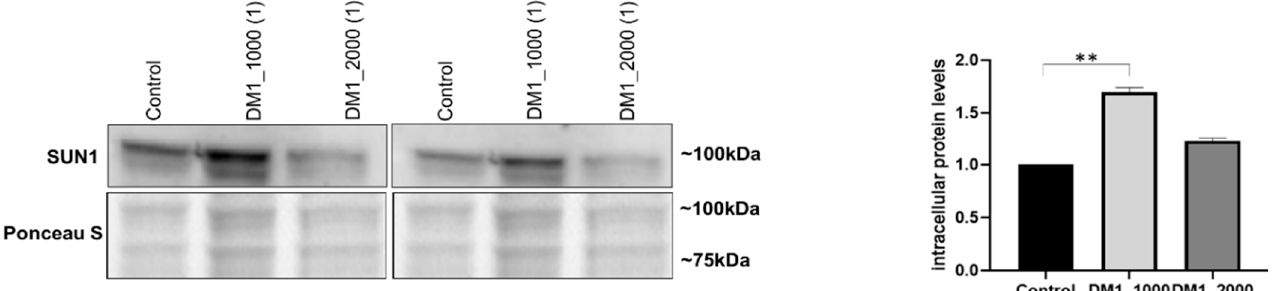
Figure 6. Intracellular protein levels of SUN1 in DM1 patient-derived and control fibroblasts. The intracellular protein levels in DM1 patient-derived fibroblasts were estimated in relation to protein levels detected in the control condition and are presented as mean ± SEM of three independent experiments. Ponceau S staining was used to assess gel loading. The statistical analysis was performed using one-way ANOVA followed by Tukey’s multiple comparison test to compare between DM1_1000, DM1_2000 and the control groups. ** p < 0.01; DM1—myotonic dystrophy type 1; SEM—standard error of the mean; SUN—Sad1/Unc-84.